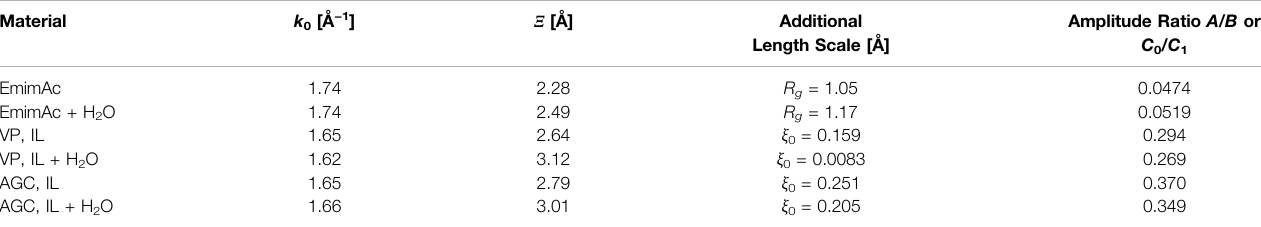
TABLE 2 | The parameters of the fi ts to the XRD scattering curves from Figure 3 , using the models described in Noferini et al. [8]. The errors of k 0 are less than 1%, of ξ are less than 2%, of the additional length scale are less than 4%, and of the amplitude ratios are less than 2%. Material k 0 [Å − 1 ] Ξ